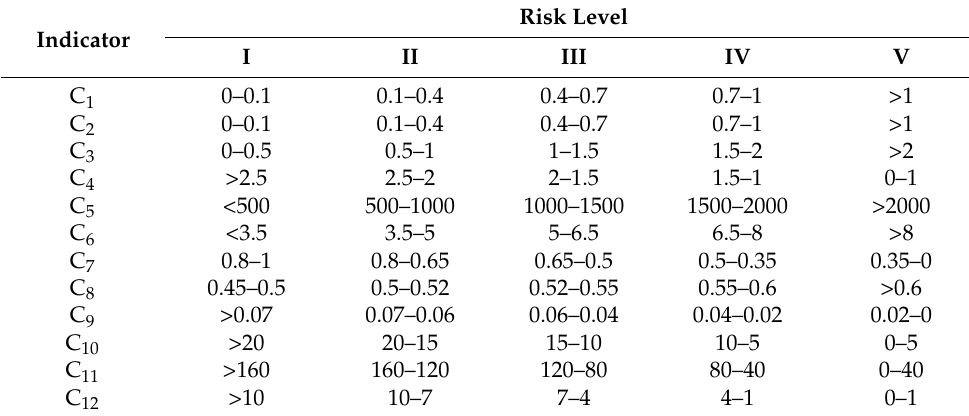
Table 4. Grading table of evaluation indexes.